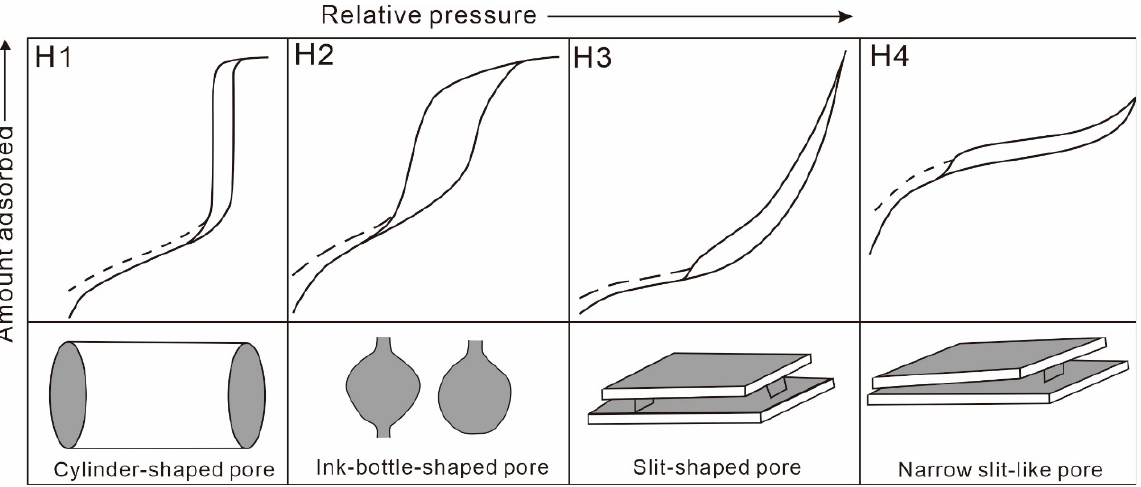
Figure 13. Hysteresis patterns and their corresponding pore shapes (modified from Sing [76]).